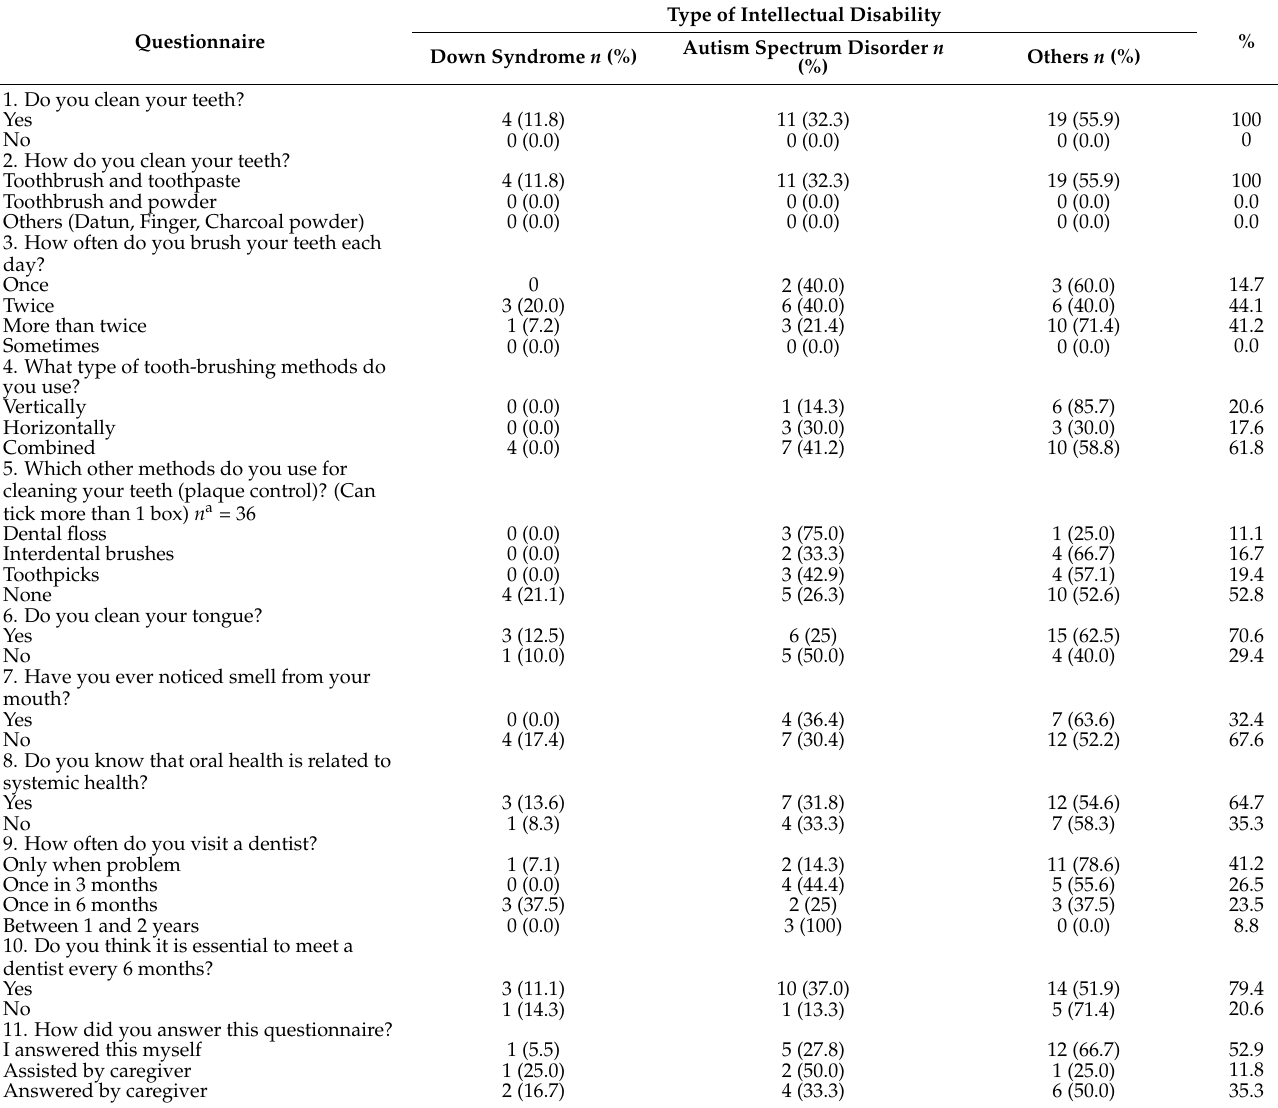
Table 2. Questions and Responses of Participants According to Their Medical